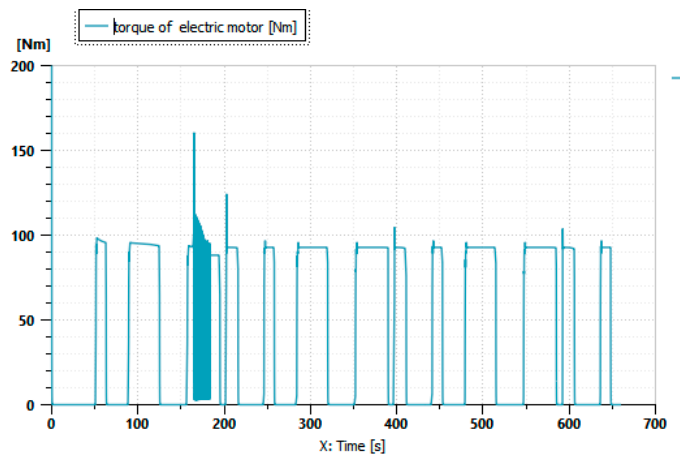
Figure 7. Electric motor torque.